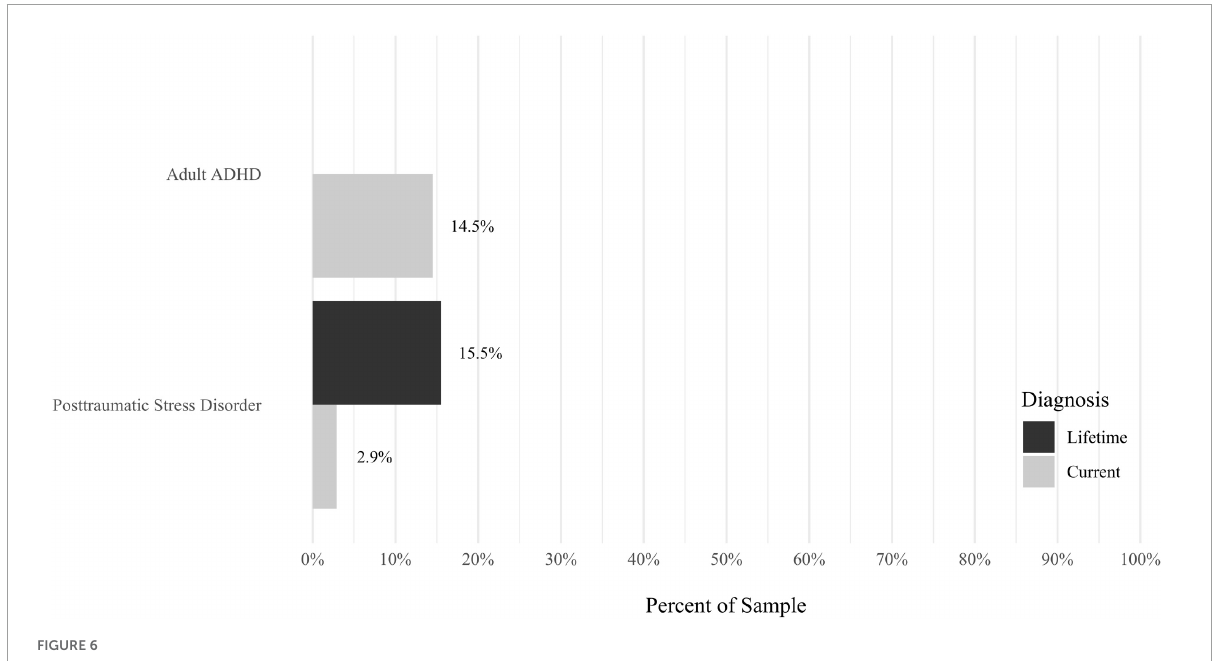
FIGURE6 Rates of psychiatric disorders: other disorders.